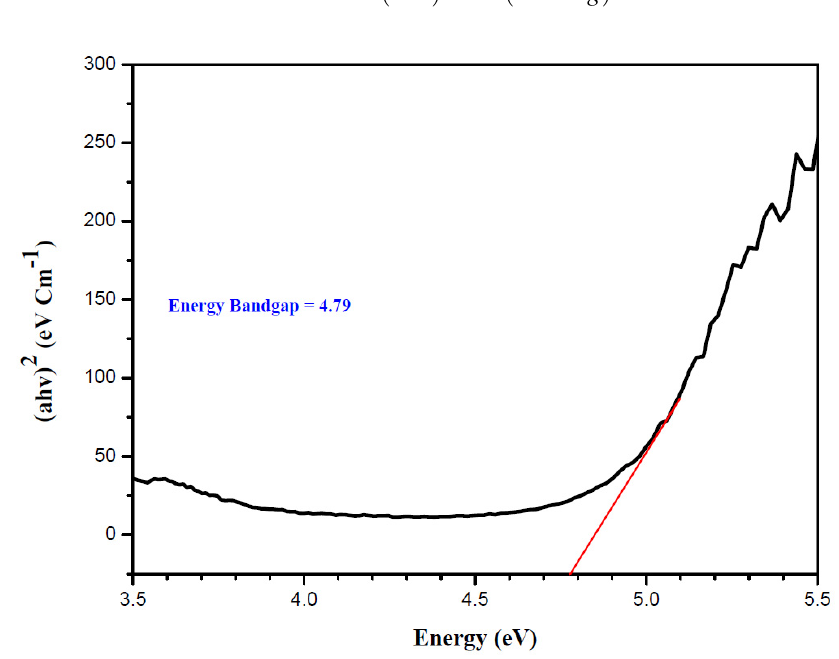
Figure 6. The energy band gap of extracted SNPs.